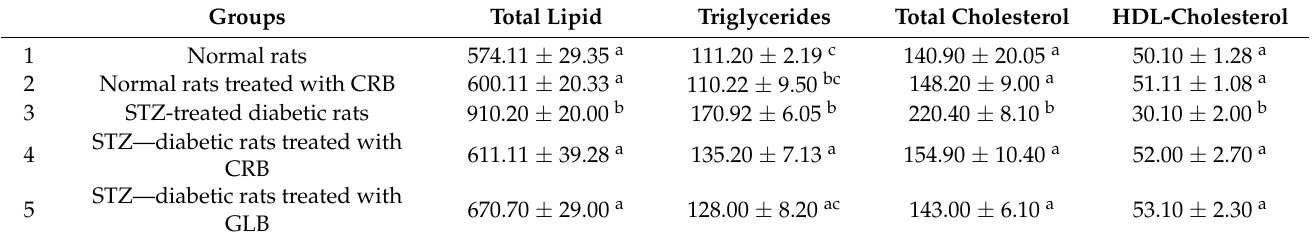
Table 3. Effect of the n-butanol fraction of Colvillea racemosa total extract (CRB) orally administered on lipid profile (mg/dL) in Streptozotocin (STZ)-induced diabetic rats.